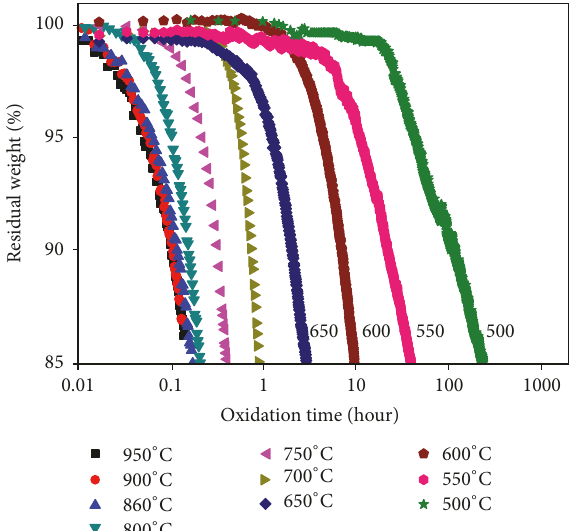
Figure 2: The relationship between the weight loss and oxidation time at different